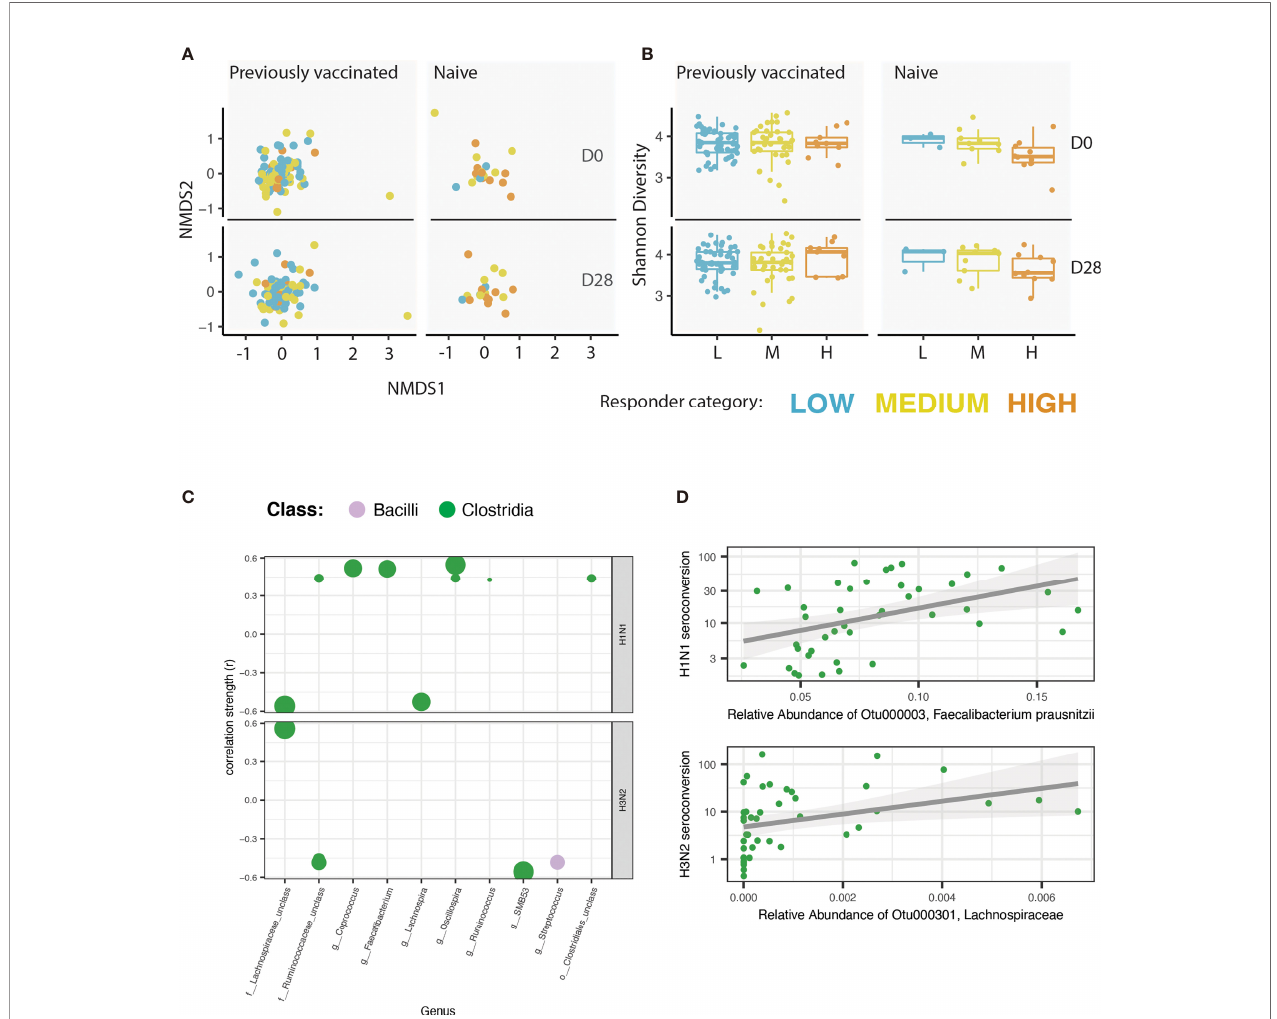
FIGURE 2 | A unique microbiome signature is correlated with the vaccine response to each of the in fl uenza strains. (A) Non-metric multidimensional scaling (NMDS) of the microbiome for each participant. NMDS is faceted by vaccination history (naïve vs . previously vaccinated) and by timepoint [pre-vaccine (D0) or 25 - 28 days post vaccine (D28)]. Colour of each point re fl ects the responder category of the participant. (B) Shannon index of alpha diversity. Plot is faceted by vaccination history (naïve vs . previously vaccinated) and by timepoint (pre-vaccine or 28 days post vaccine). Colour of each point re fl ects the responder category of the participant. (C) Correlation analysis showing the strength of Spearman correlation of operational taxonomic units (OTUs) with HAI seroconversion in individuals previously naïve to in fl uenza vaccination. Each point is one OTU. Colour of each point represents the class level taxonomic assignment of each OTU. OTUs are organized (x-axis) by genus, or by the lowest level of taxonomic hierarchy determined. Size of each point corresponds to -log (P value). Only OTUs with a correlation coef fi cient > |0.15| and an adjusted P value < 0.05 are shown. Plot is faceted by in fl uenza strain: H1N1 (top), H3N2 (bottom). (D) Scatter-plot showing the correlation between the OTU with the strongest correlation with H1N1 seroconversion (Faecalibacterium prausnitzii; top) and H3N2 seroconversion (identi fi ed to the family level as Lachnospiraceae;